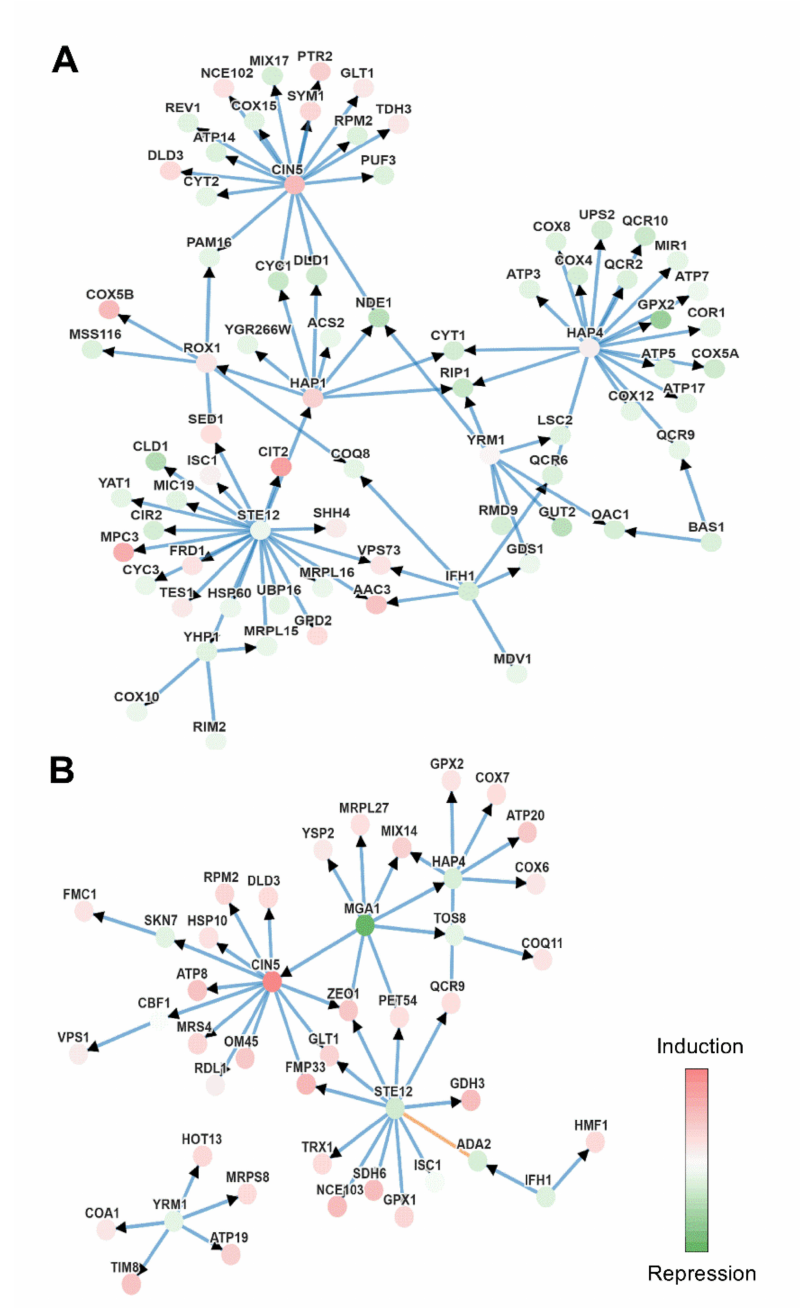
Figure 7. Genetic interactions given by Phenetics using mitochondrial genes with − 1 < FC < 1, p -value < 0.05. Set of genes used in each comparation: ( A ) Mel vs. Control. ( B ) MelH vs. H. Nodes represent molecular entities, and the intensity of its color represents the level of di ff erential expression, green being under-expression and red over-expression. The edges indicate the interaction between the genes (blue indicates protein-DNA and orange protein-protein), and the arrows the direction of the